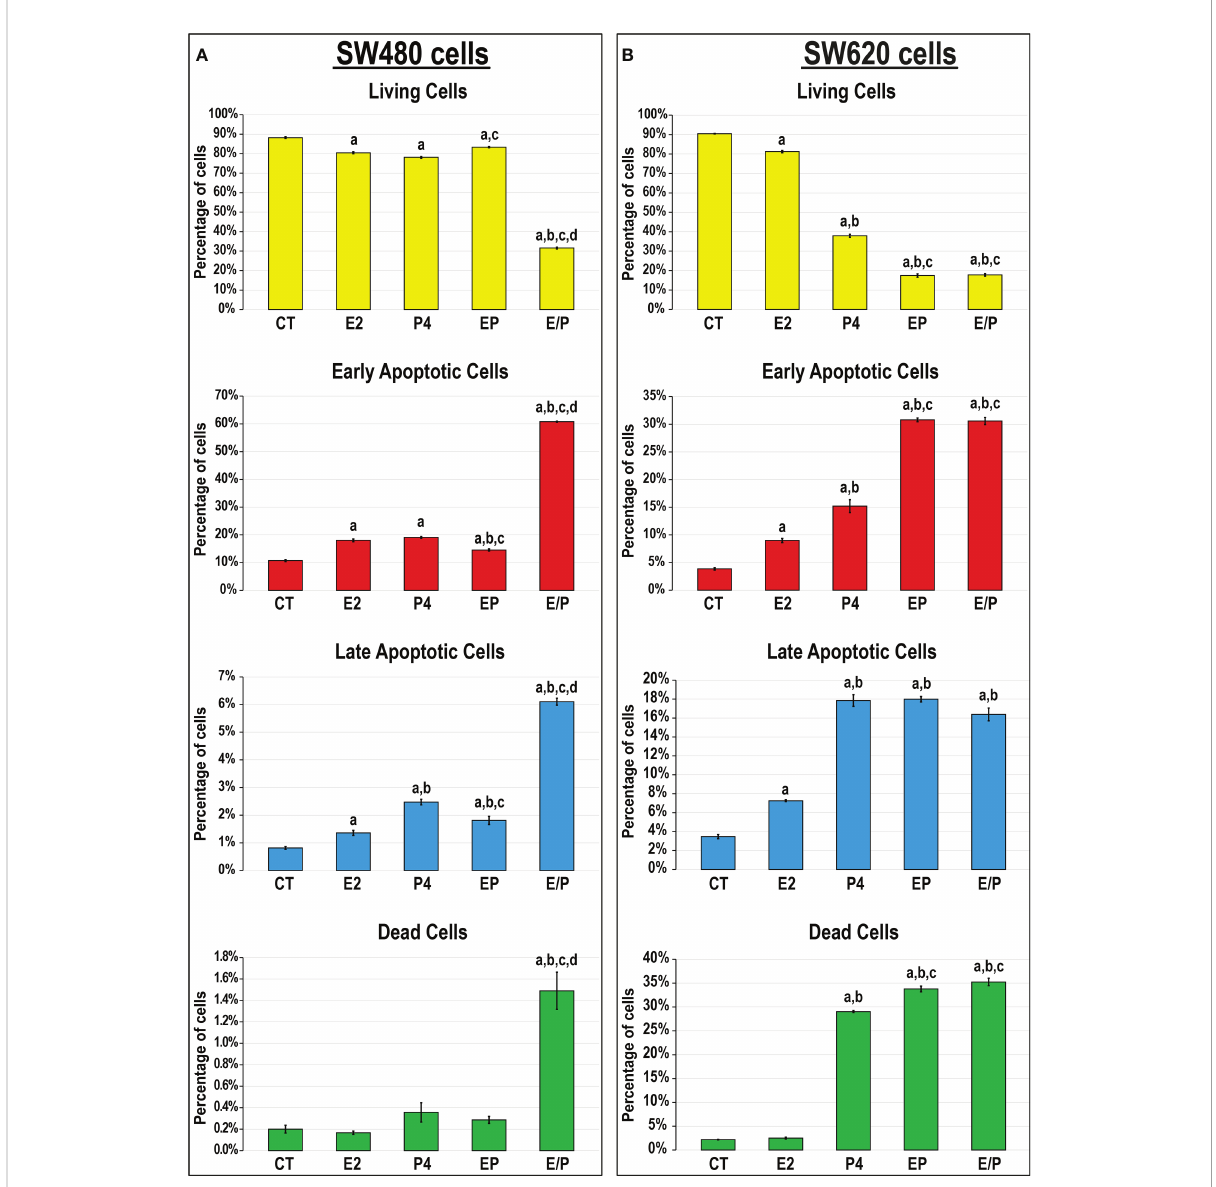
FIGURE 6 Percentages (mean ± SD) of living, early and late apoptotic alongside dead cells following the different treatment protocols with E2 and/or P4 for 48 hours in the (A) SW480 and (B) SW620 male colon cancer cell lines (mean ± SD; a P< 0.05 compared with the CT group; b P< 0.05 compared with the E2 monotherapy group; c P< 0.05 compared with P4 monotherapy and d P< 0.05 compared with EP concurrent dual therapy